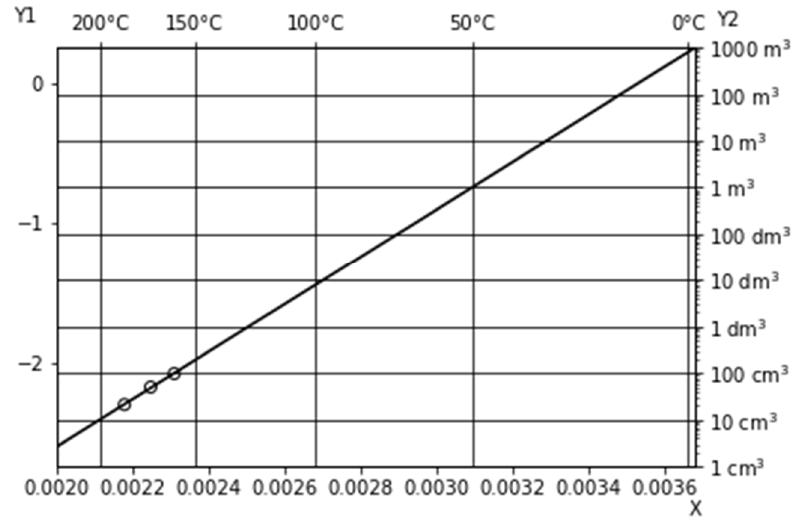
Figure 12. Pseudo-Arrhenius graph of the self-ignition temperature of the sludge pellets.